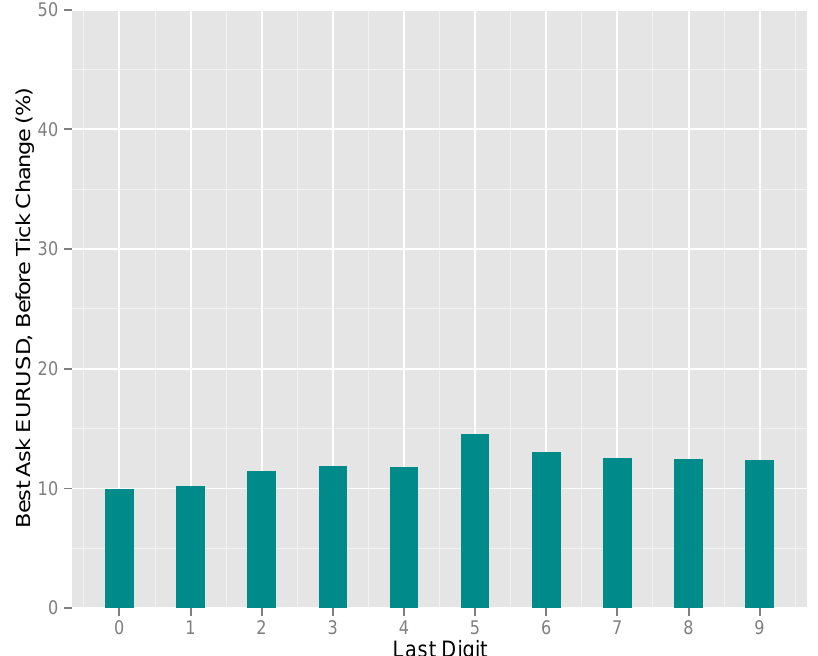
Figure 17. Best Ask Last Digits, Before Tick Change.